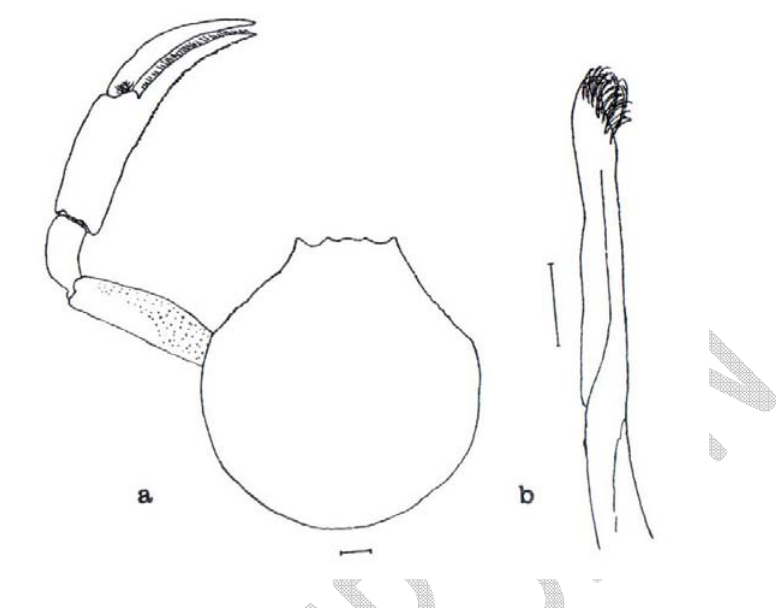
8._ Philyra platycheir de Haan, 1841 : a, carapace; b, first gonopod. Scale: 1 mm. F IG . proximal part, fingers nearly as long as the manus, slightly curved, cutting edge of immovable finger with a visible line of long hair (discriminative character of this species) and denticulate beyond the line of hair. The first gonopod (Fig.8-b) long, straight, with hairs in the apical part.